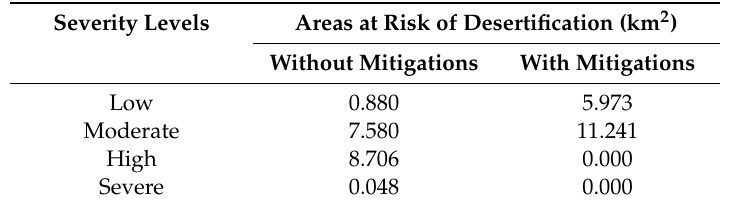
Table 5. Risk levels of the area with and without area restoration.